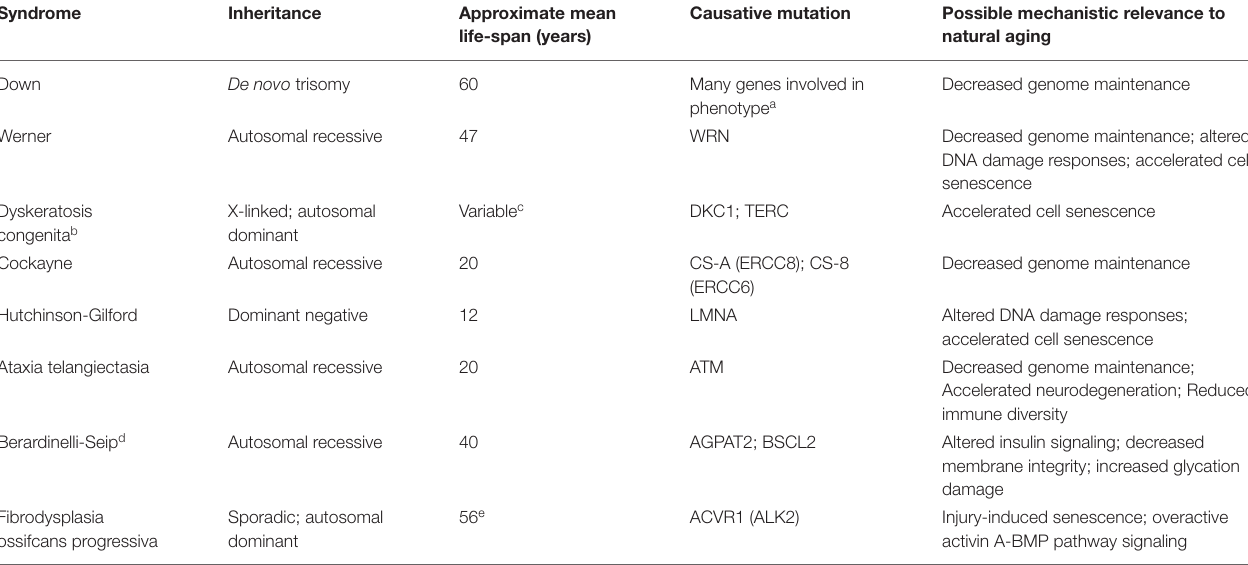
TABLE 1 | Representative segmental progeroid syndromes including FOP (4–7).